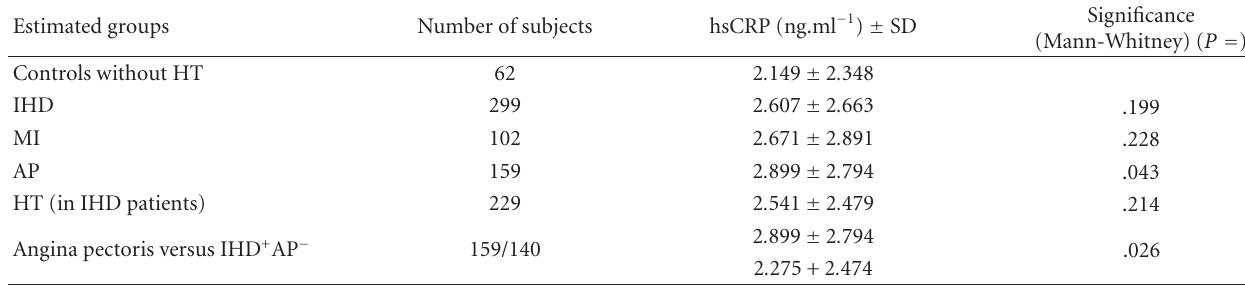
Table 1: Serum levels of hsCRP in patients with IHD, MI, AP, and hypertension and in control group of healthy subjects. Legend: IHD: ischemic heart disease; MI: myocardial infarction; AP: angina pectoris; HT: hypertension. Estimated groups